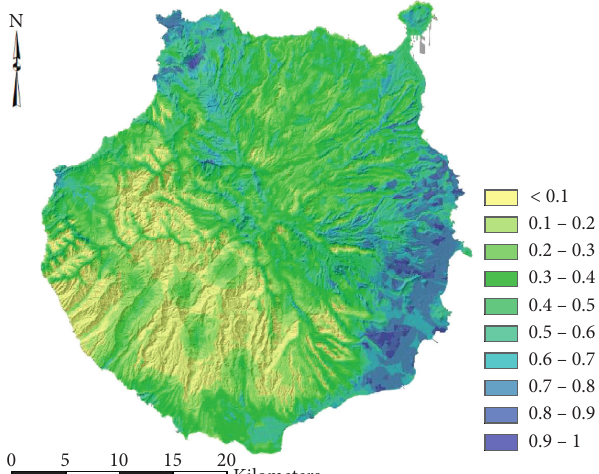
Figure 3: Wind evaluation